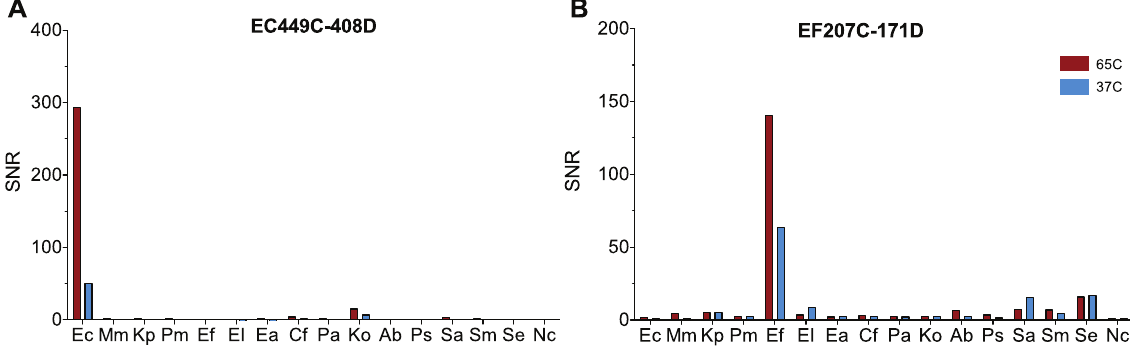
Figure 2. Comparison of biosensor pathogen detection using 35-bp probes at 65 and 37 6 C. Probe selectivity and sensitivity was tested against different uropathogens. A. The biosensor signal for detection of E. coli with EC449C-EC08D was 1996 nA at 65 u C compared to 1270 nA at 37 u C and this probe set showed non-specific binding with K. oxytoca at both temperatures. B. The biosensor signal for detection of E. faecalis with EF207C-EF171D was 1107 nA at 65 u C and 549 nA at 37 u C and this probe set showed non-specific binding with K. pneunomiae , E. cloacae , S. aureus , S. epidermidis . The bacterial species are abbreviated on the X-axis with capital letter for genus and small letter for species.